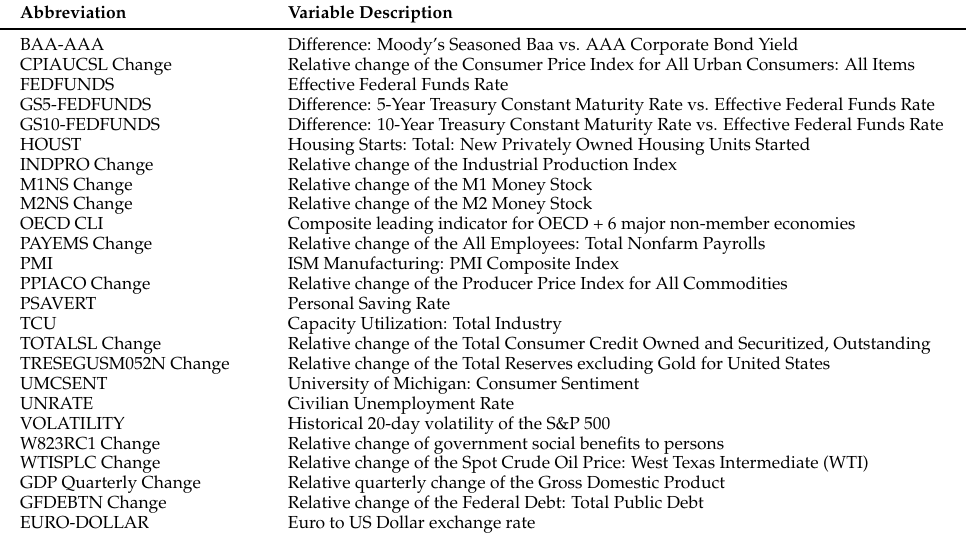
Table 1. Complete Variable List Before Input Factor Reduction (see Appendix A, Table A1 for the data